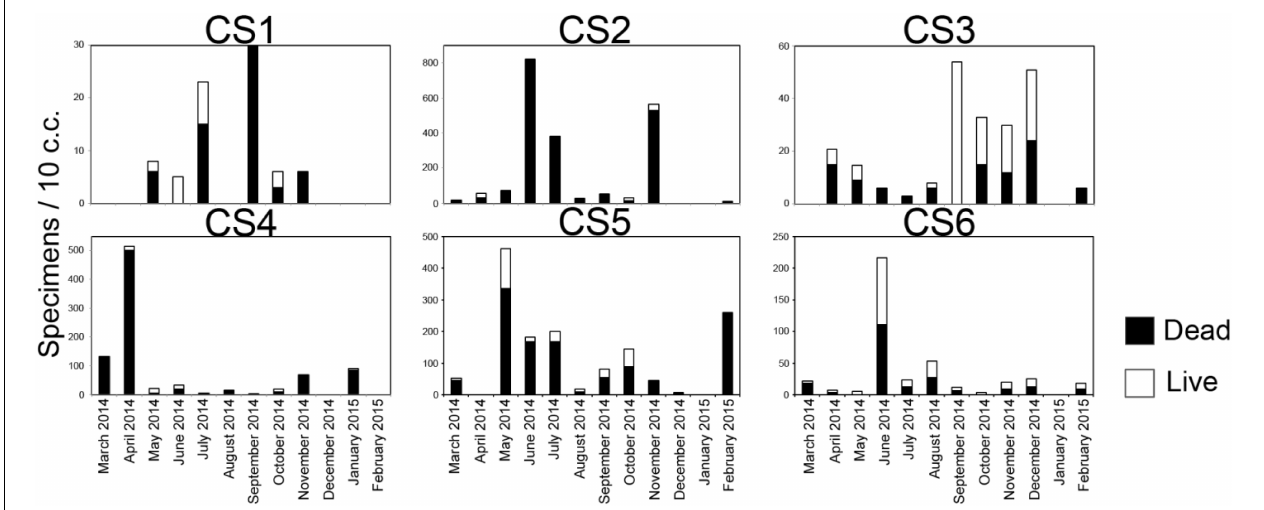
FIGURE 7 | Number of observed live and dead specimens of Ammonia spp. in 10 c.c, of surface (0–2 cm) sediment in the lagoon representing the study